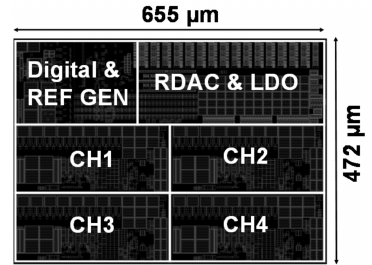
Figure 12. Layout of the proposed ADC including four channels, RDAC and digital control parts.